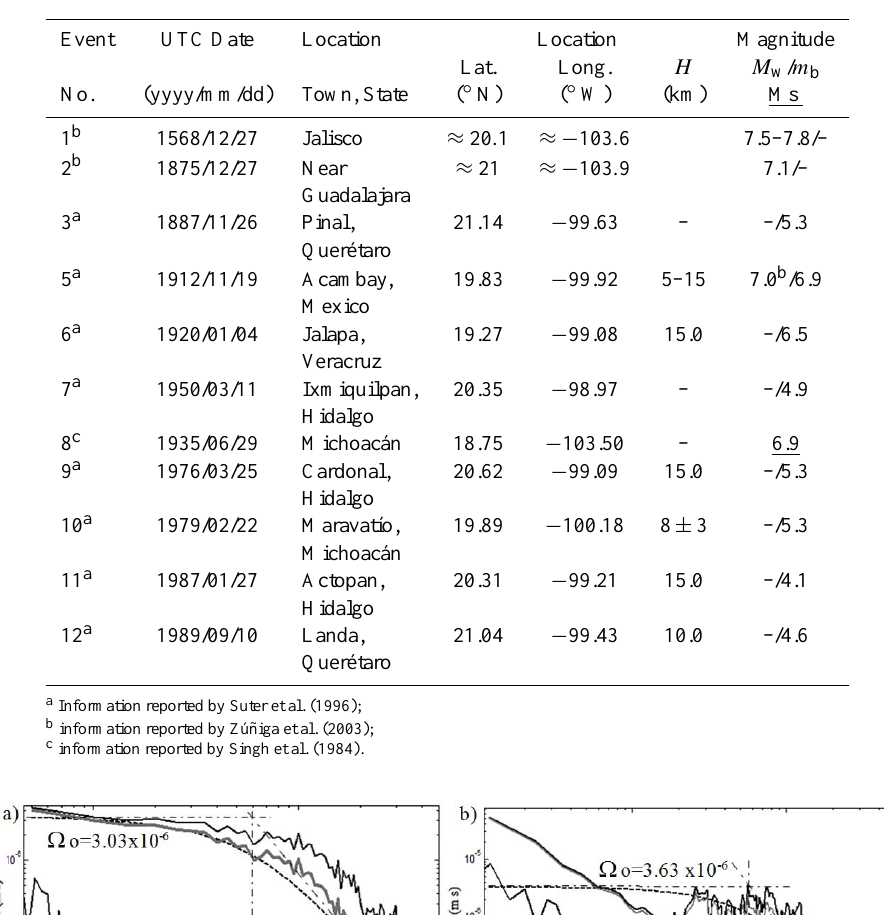
Table 7b. Relevant earthquakes in the MVB region.